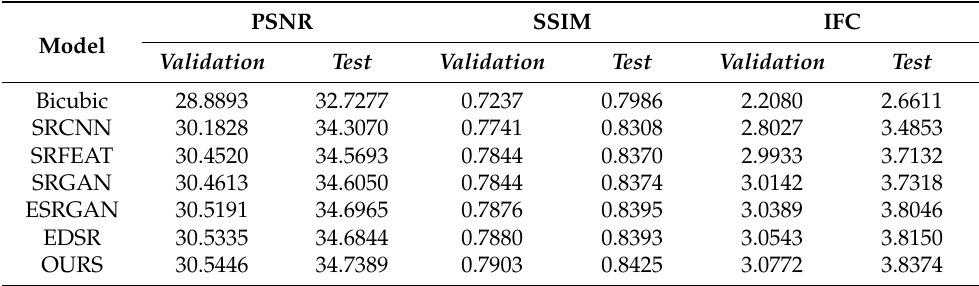
Table 1. Quantitative results of SEM image super-resolution in validation dataset and test dataset. Best results are highlighted.